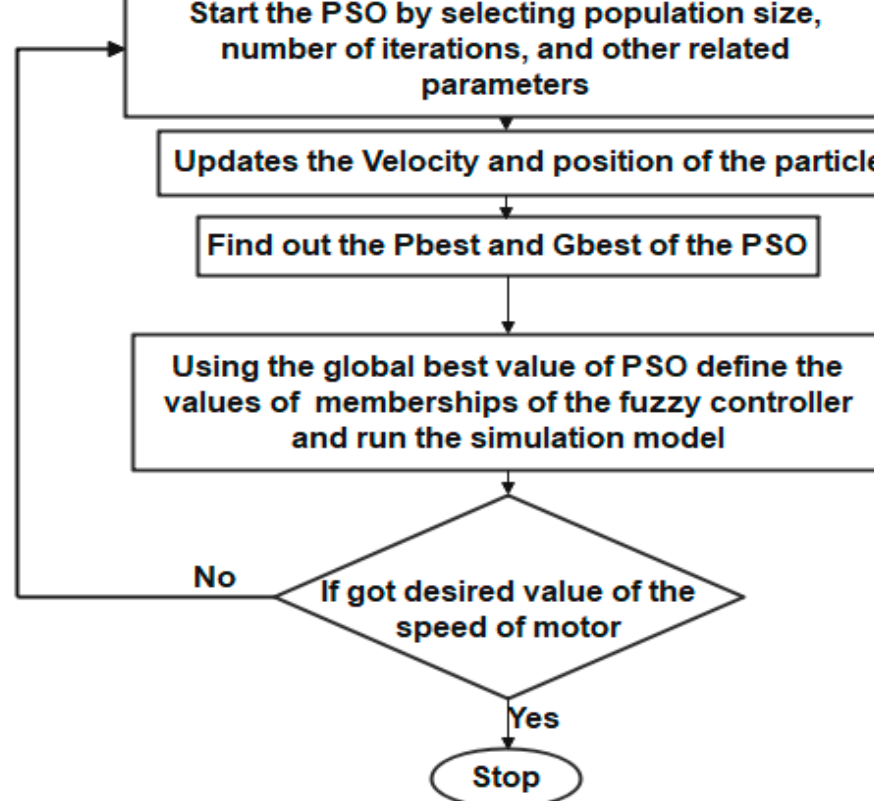
Figure 5. Flowchart of the proposed system. With the help of mathematical equations, a Simulink model of SEDC motors using MATLAB is shown in Figure